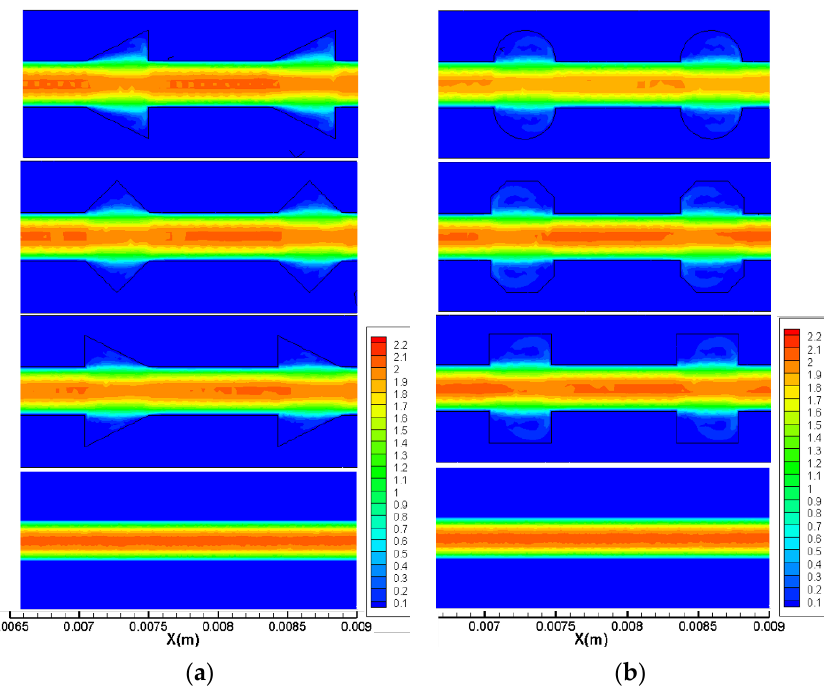
Figure 7. Local velocity distribution for Re = 400. ( a ) Group 1, ( b ) Group 2.